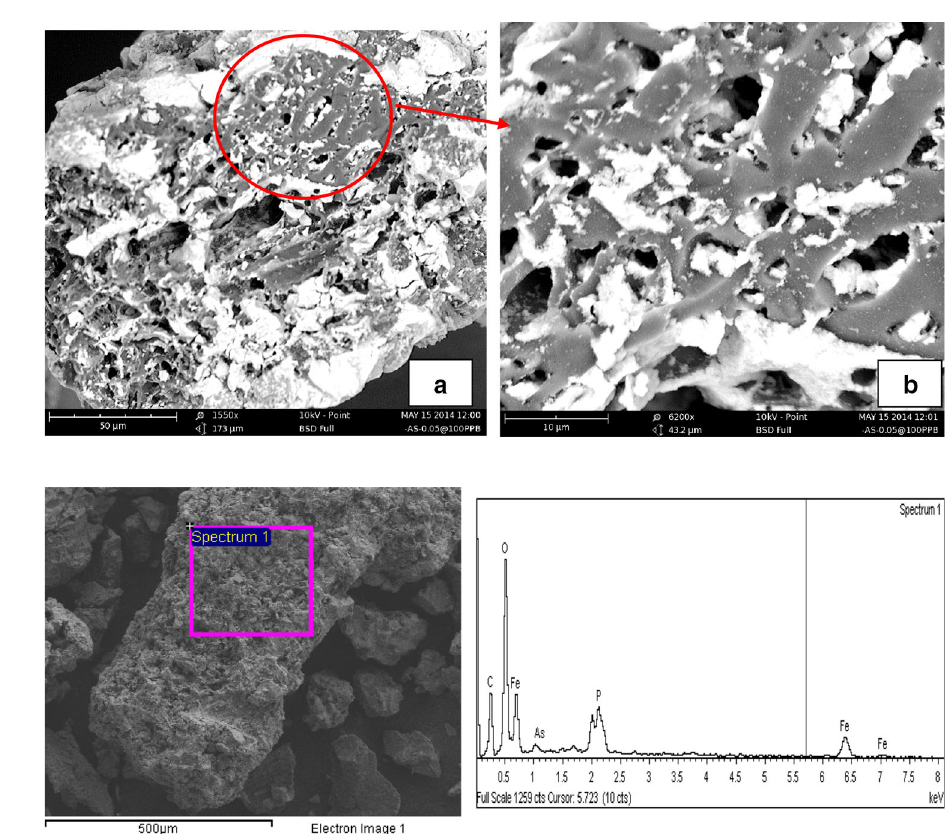
Fig. 13 Micrograph of